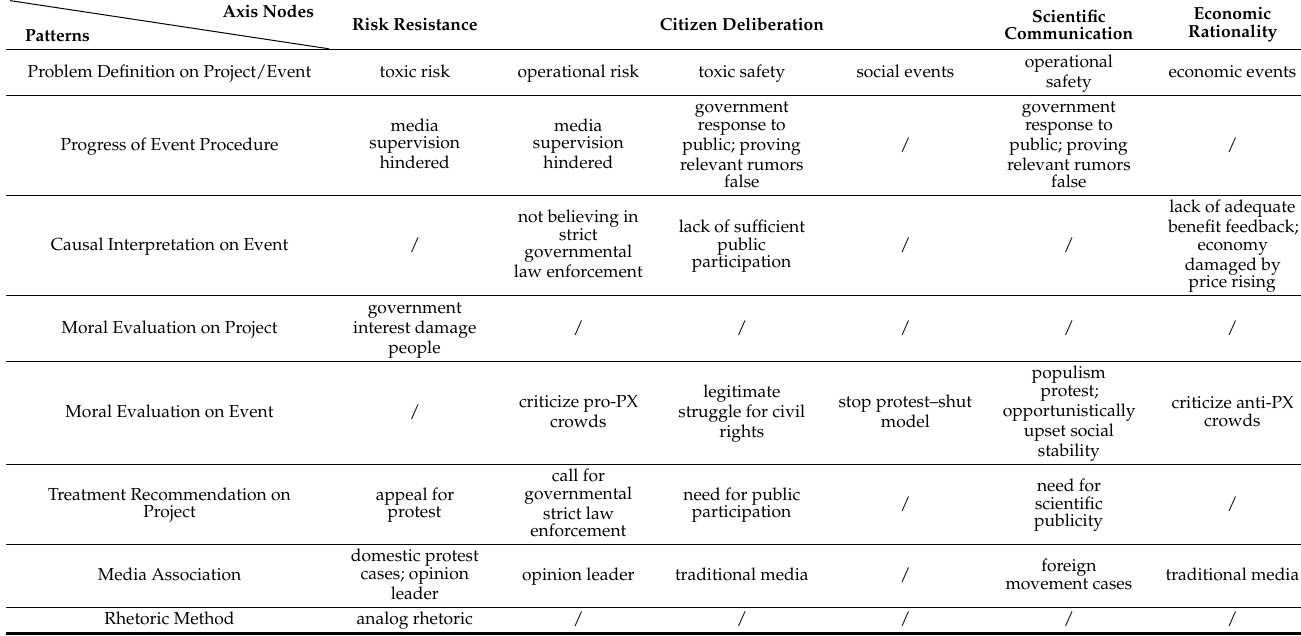
Figure 1. Main category relationship structure diagram. Table 4. The structure table of main category